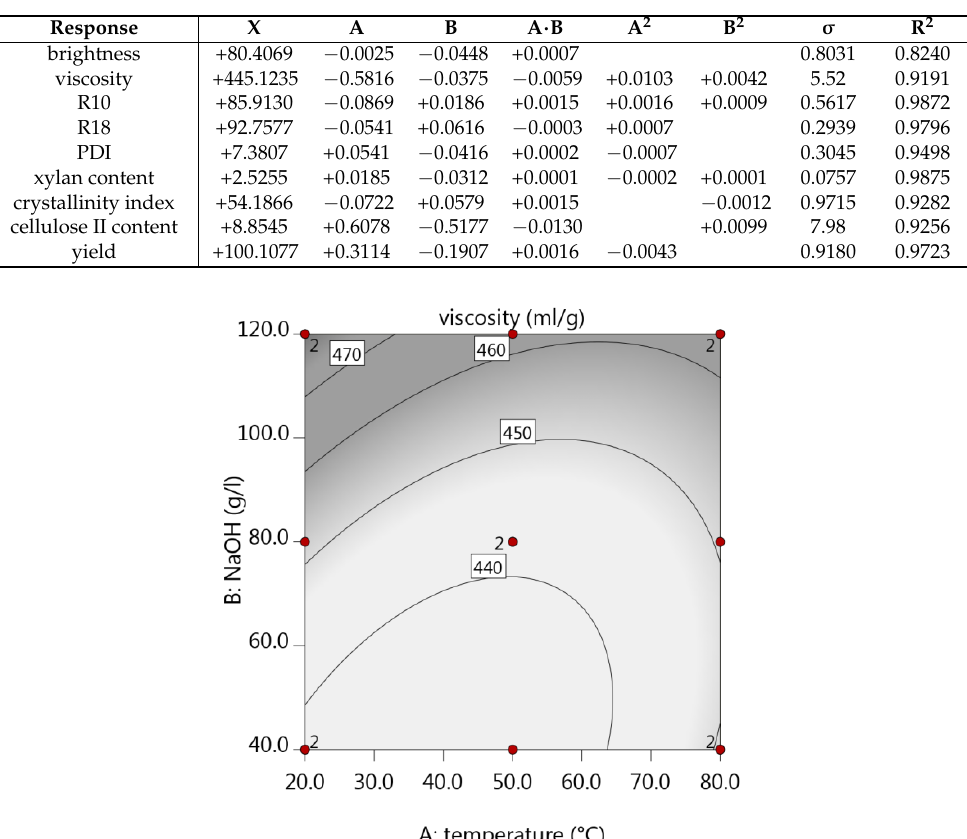
Figure A2. Response surface of brightness in correlation with temperature and NaOH concentration.